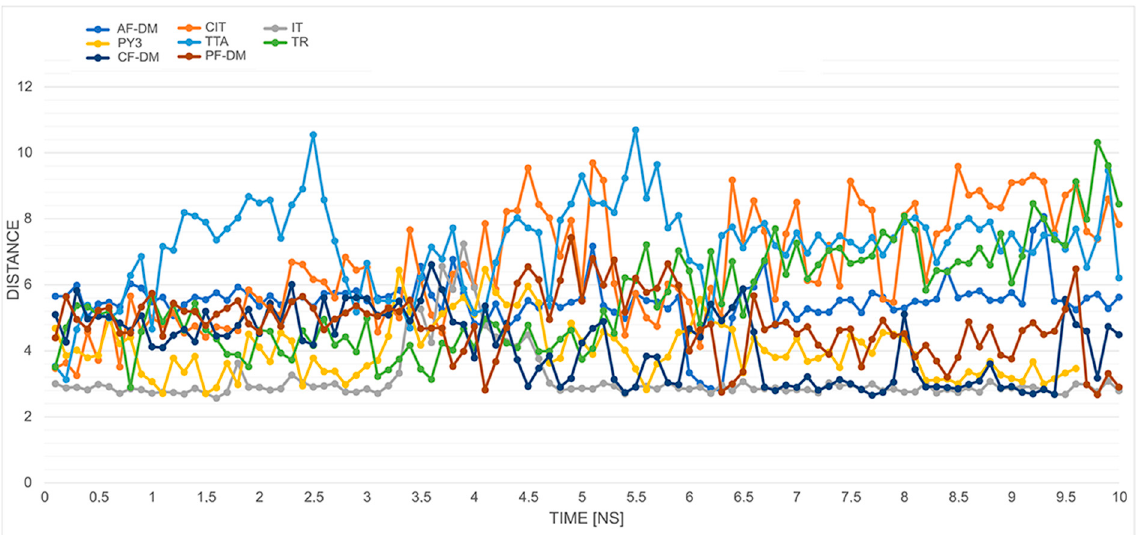
Figure 2. Ionic lock distances change for 8 apo forms GPR18 models during the 10 ns MD simulation. For colored graphs, please refer to the online version of this paper.